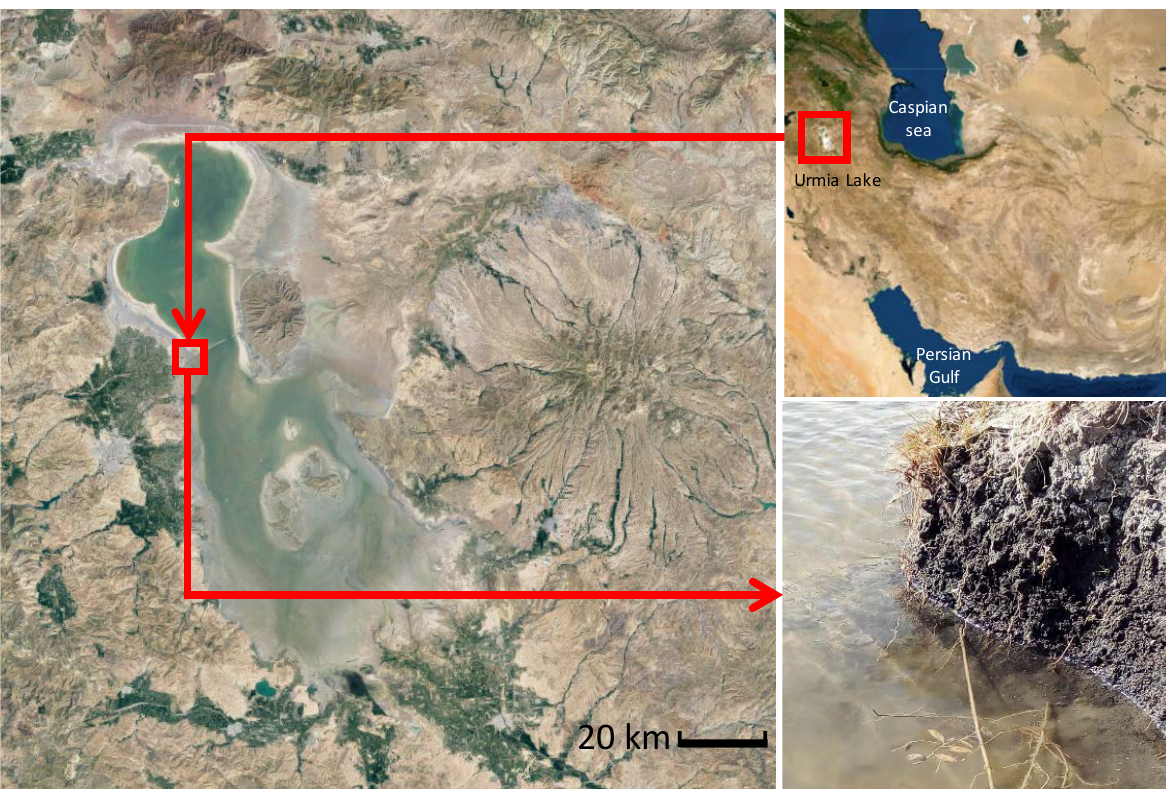
Figure 1. Left and top right: aerial images showing the location of the study site on the Urmia–Tabriz Shahid Kalantary Highway, 8 Km east of Urmia, Iran. Bottom right: the appearance of the sampled peat